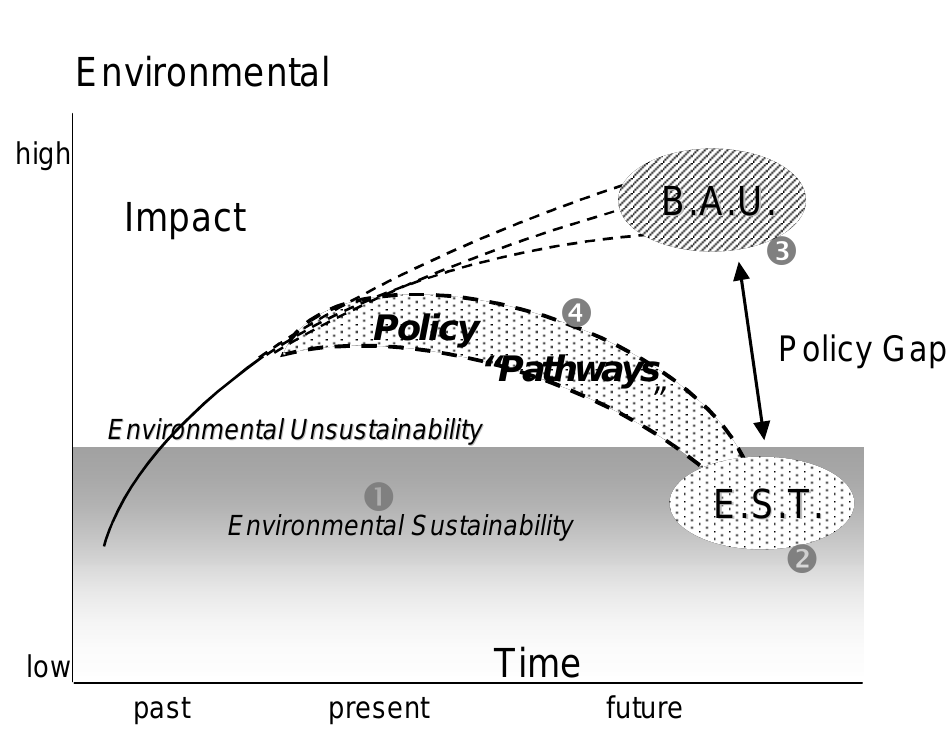
Figure 1. The EST concept and approach -Environmental sustainability targets and backcasting